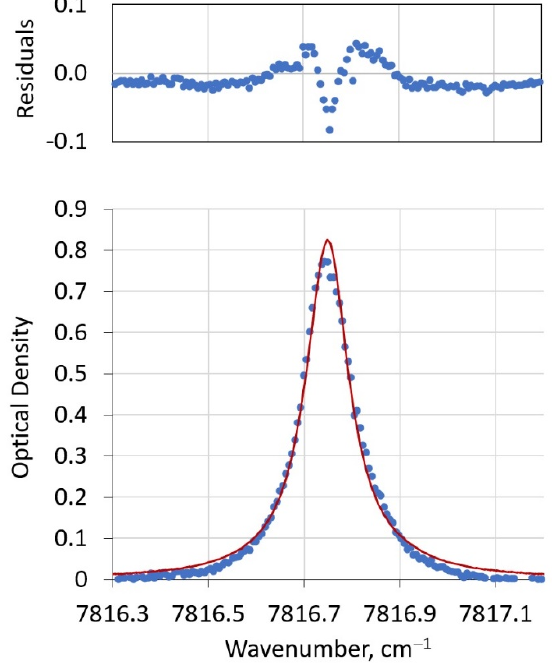
Figure 7. Lower panel: representative fit of PHOCS water feature. The upper panel shows the residuals of the fit.